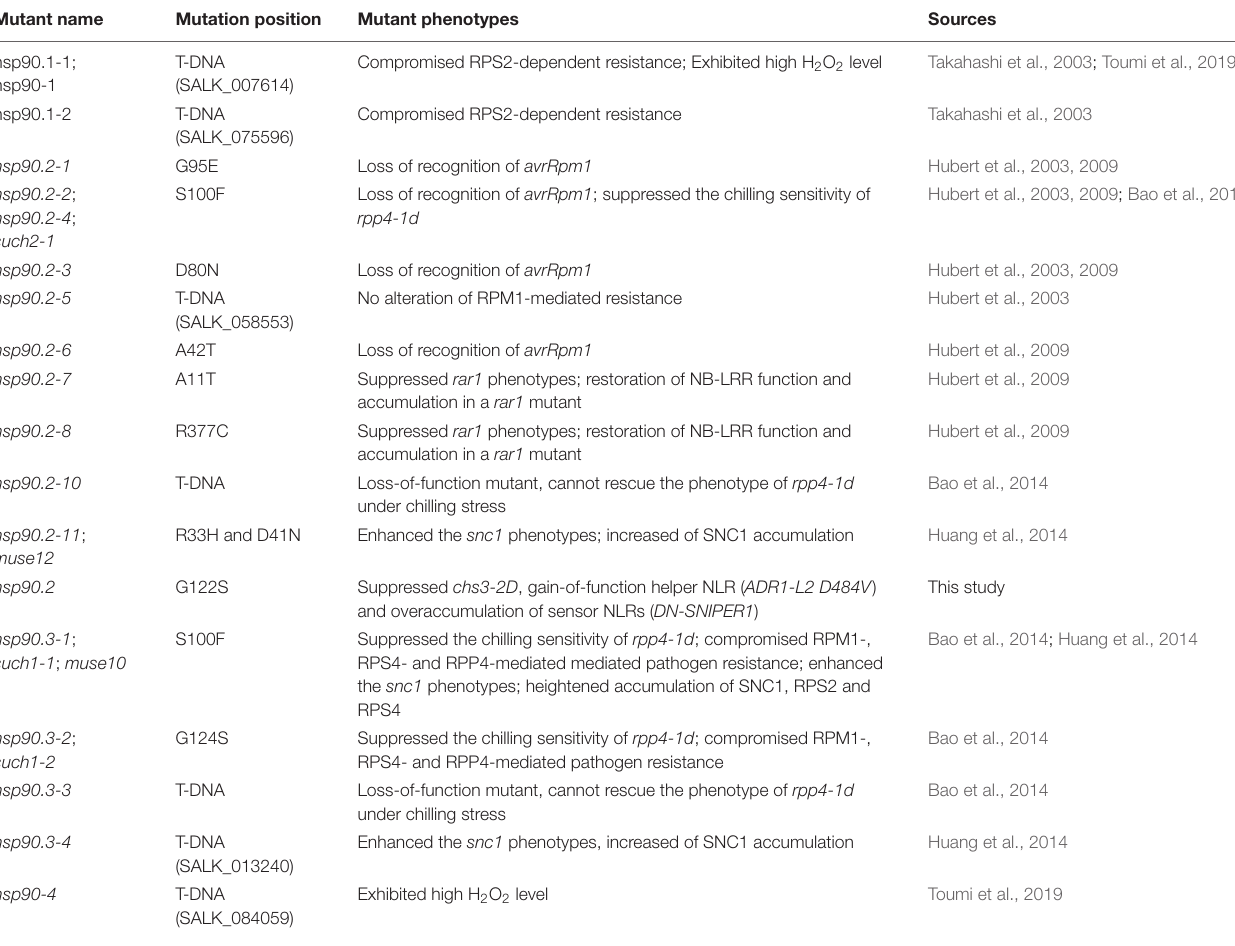
TABLE 2 | Reported hsp90 mutant alleles in Arabidopsis